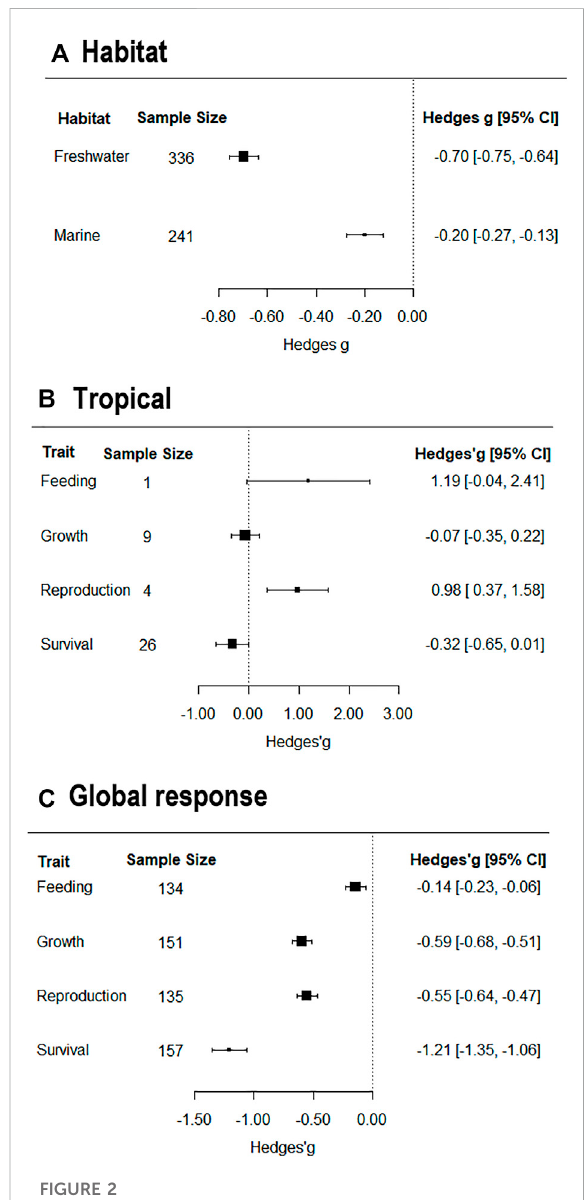
FIGURE 2 Forest plot of effect sizes by (A) Habitat (B) Tropical freshwater systems functional traits (C) Global response traits. Analyses were conducted using a mixed-effects model. Black boxes denote the hedges ’ g value and horizontal lines denote the 95% con fi dence intervals (CI) for each hedges ’ g value. Hedges ’ g values of less than 0.2 represent small effects, values between 0.2 and 0.5 represent moderate effects, with values greater than 0.5 suggesting large effects. The relative size of the blackboxesshowstherelativeeffectsizeofthestudiesincludedin each